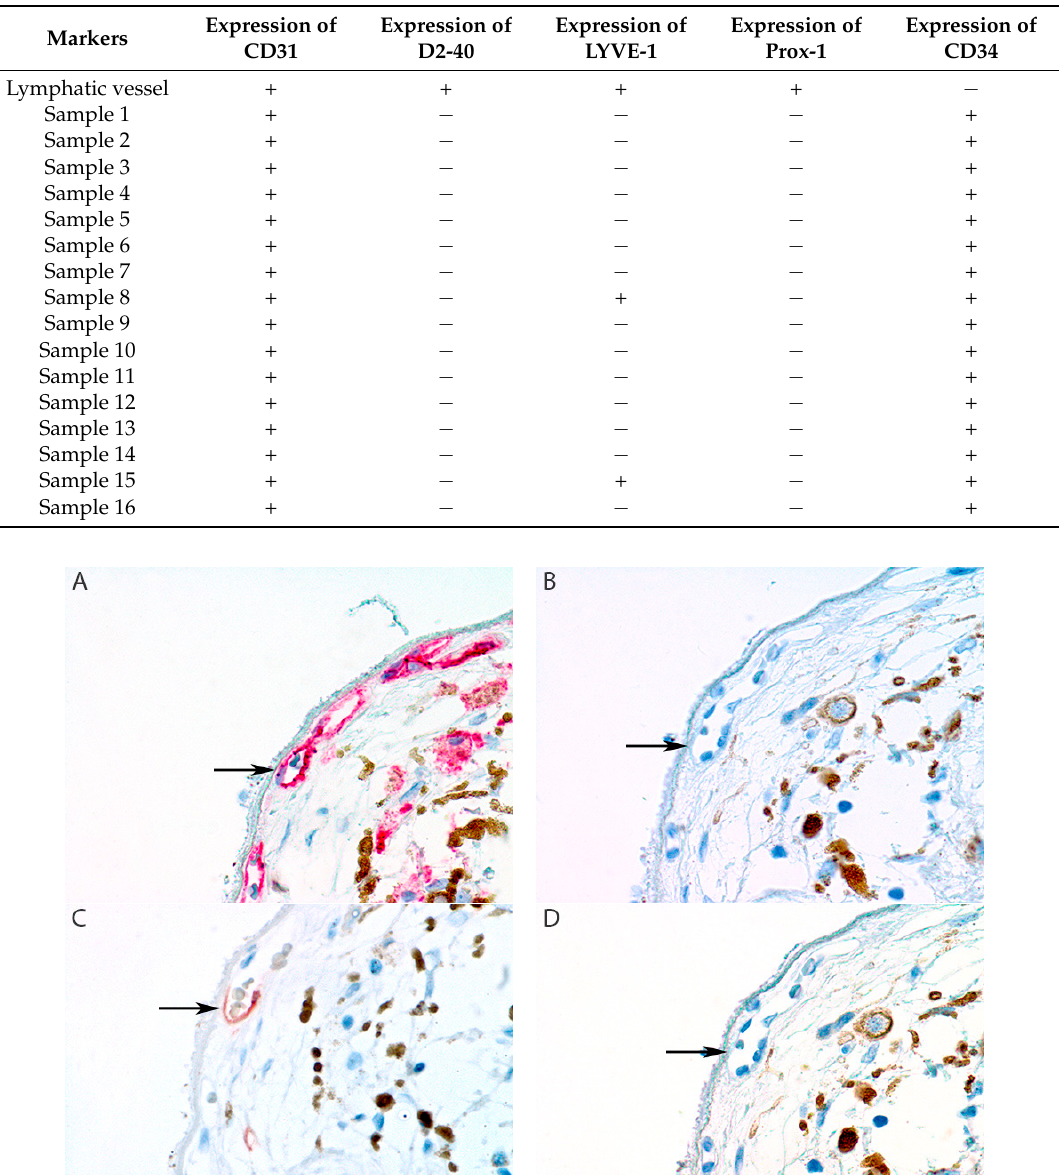
Table 2. Required expression profile of lymphatic vessels and patient samples. CD—cluster of differentiation; D2-40—podoplanin; LYVE-1—lymphatic vessel endothelial hyaluronic acid receptor-1; Prox-1—prospero-related homeobox gene-1.